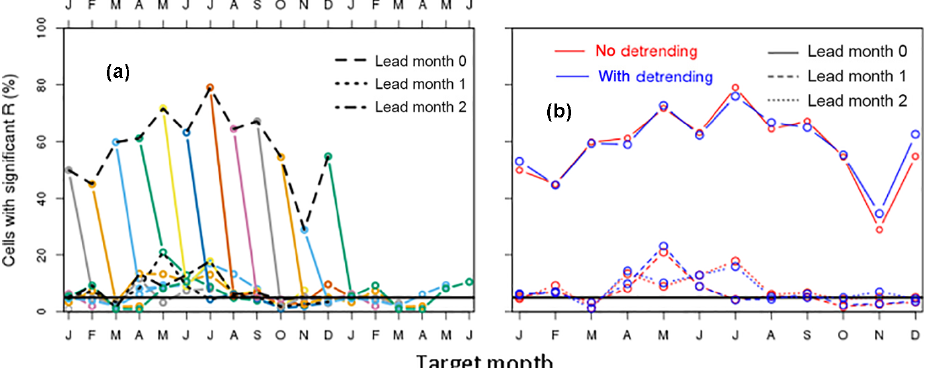
Figure 3. Skill of the incoming short-wave radiation hindcasts after bias correction. (a) gives the percentage of cells with significant values of R (see Fig. 1b for further explanation). (b) compares annual cycles of skill of un-detrended and detrended data for the first 3 lead months (see c for further